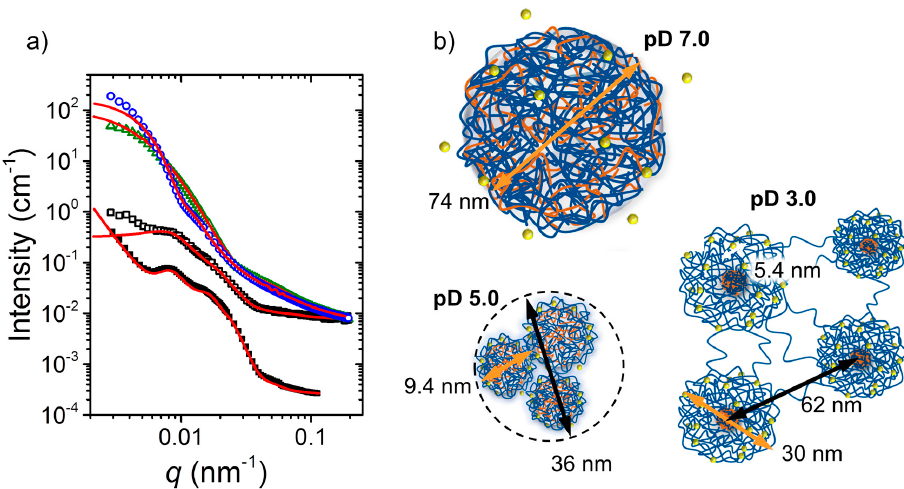
Figure 4. SANS results from A(QP)A 2 and APA 2 . Data from [34]. ( a ) Scattered intensity, I ( q ), as a function of the momentum transfer, q , of solutions of A(QP)A 2 at pD 7.0 (open blue circles), pD 5.0 (open green triangles) and pD 3.0 (open black squares), and APA 2 at pD 3.0 (closed black squares, shifted vertically for clarity). All scattering curves were measured at a concentration of 4 wt % and at 26 °C. The red lines are the model fits. ( b ) Corresponding nanostructures at the pH values given. Blue lines: QP, orange lines: A, yellow circles: counter ions. Average length scales are given. Adapted with permission from [34]. Copyright 2014 American Chemical Society.